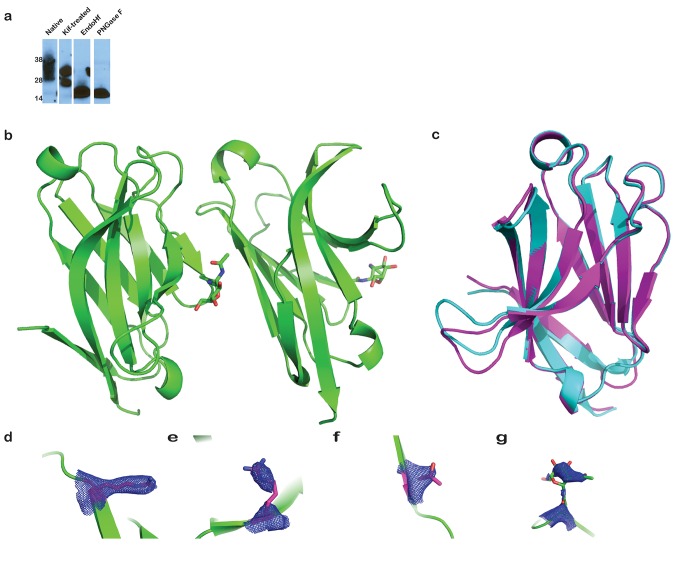
Analysis of TREM2 glycosylation, comparison of TREM2 monomers in the crystal structure, and SA-omit maps of AD-linked residues.(a) Immunoblot (anti-6His) analysis of secreted WT hTREM2 ectodomains. From left to right: natively glycosylated and secreted hTREM2 ectodomain, hTREM2 ectodomain secreted from kifunensine-treated cells, EndoHf-digested ectodomains from kifunensine-treated cells (which have a single N-acetylglucosamine residue at the two N-linked sites), and PNGaseF-digested TREM2 ectodomain from kifunensine-treated cells (from which the entire glycan has been removed). (b) The hTREM2 asymmetric unit (ASU) contains two monomers of the TREM2 ectodomain. Note that the NAG (shown in sticks) participates in the interface, suggesting that the full-length glycan would disrupt this interaction observed in the crystal. (c) Chain A and B superimposed (Cα RMSD < 1 Å). Chain A is magenta and Chain B is cyan. The only notable difference between the two monomers is the loop in chain B, which makes lattice contacts with symmetry-related B-H103 and is slightly shifted compared to chain A, which does not make lattice contacts. (d–g) Simulated annealing composite omit maps (2mFo-DFc) contoured at 2σ around residues (d) R47, (e) R62, (f) T96, and (g) N79-NAG.